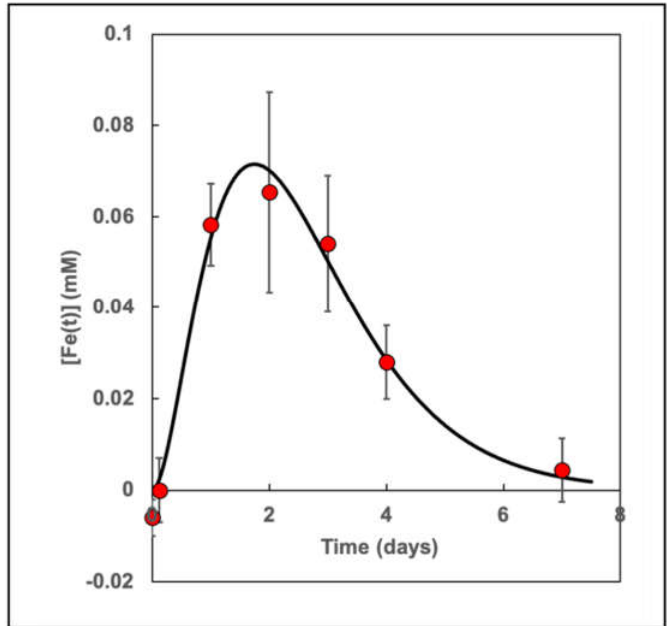
Figure 8. The dynamics of [Fe(t)] in the tumors after the injection of SPIONs as determined from the 3D [Fe(t)]MRI data. The red data points are measurements from eight slices each of 2 mice. Note that the uptake of iron is very small at 2.9 h (0.12 days). The black line is a fit to a gamma-variate function (see Section 2) with parameters A = 0.1165 mM, t 0 = 0.3453 days, and t h2 = 0.874 days. The mean transit time for the SPIONs was found to be 2.62 days. The maximum in the [Fe(t)] was found at 1.75 days (42 h).